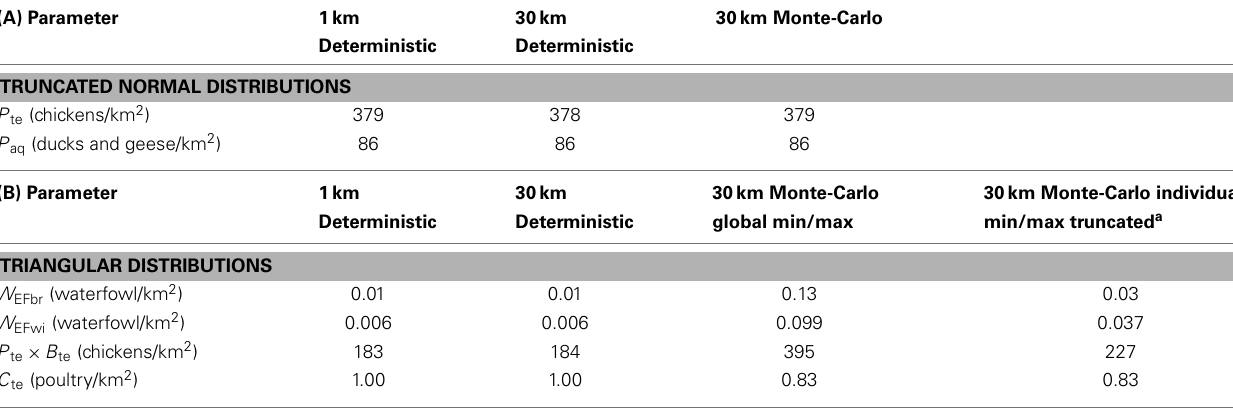
Table 3 | Comparisons of mean model outputs for 1km deterministic, 30km deterministic, and 30km Monte-Carlo models of H5N1 transmission risk between wild and domestic birds in